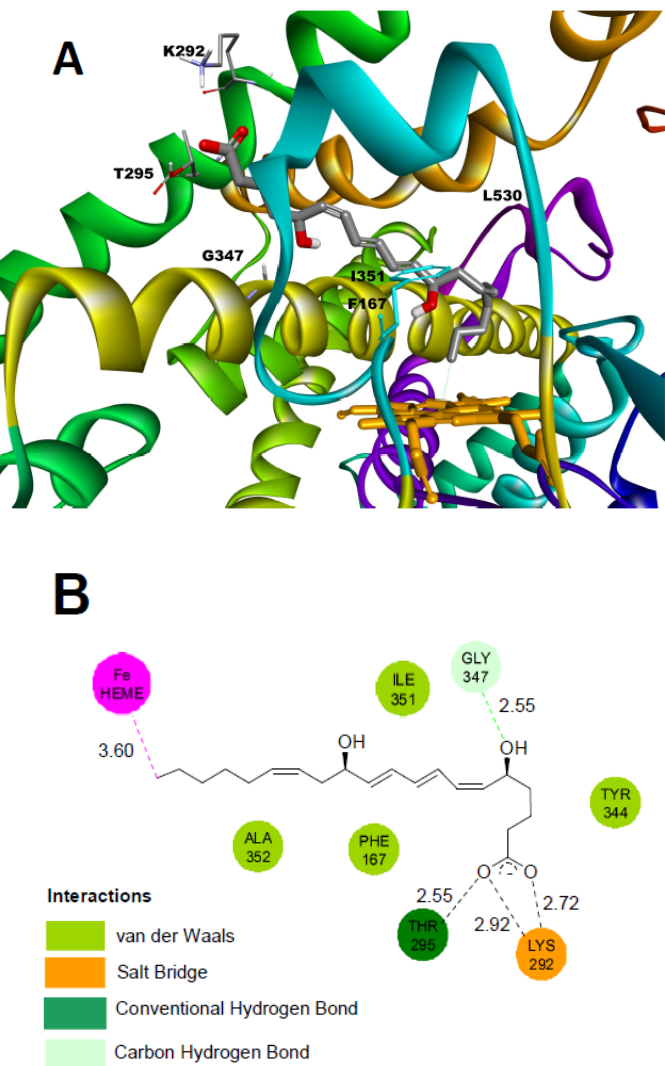
Figure 3. Docking of LTB 4 in the CYP2U1 3D model. ( A ): Pose illustrating the most energetically favored situation with the C20-atom of LTB 4 close to the iron (distance Fe-C: 3.60 Å). The protein is shown in cartoon representation with the BC loop colored in blue, the helix I in yellow, helix G in green and helix F in orange. The heme (orange) and LTB 4 (grey) are shown in stick representation with O-atoms in red. ( B ): 2D Representation of the predominant interactions between LTB 4 and the protein.